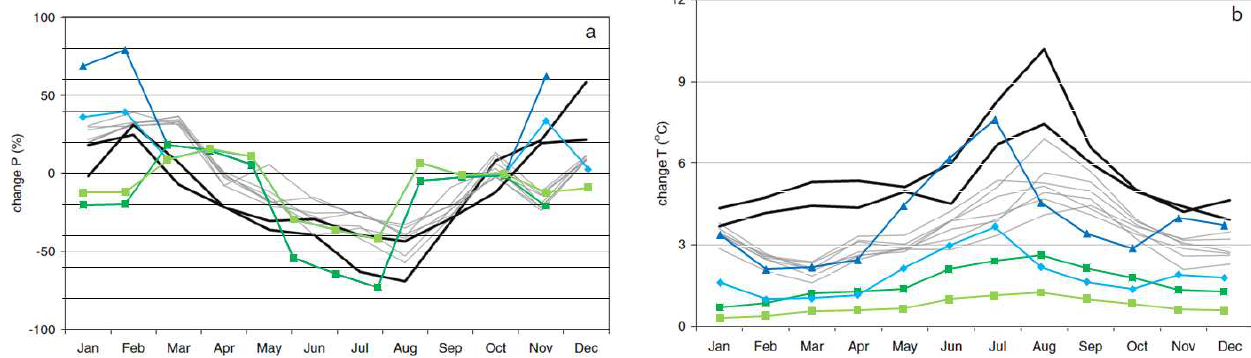
Fig. 3. CCI-HYDR high (blue) and low (green) scenarios for 2020–2050 (light colors) and 2070–2100 (dark colors) vs. PRUDENCE RCM simulation for 2071–2100 (black and grey curves) (de Wit et al., 2007). (a) Precipitation changes in %, (b) temperature changes in ◦ C.